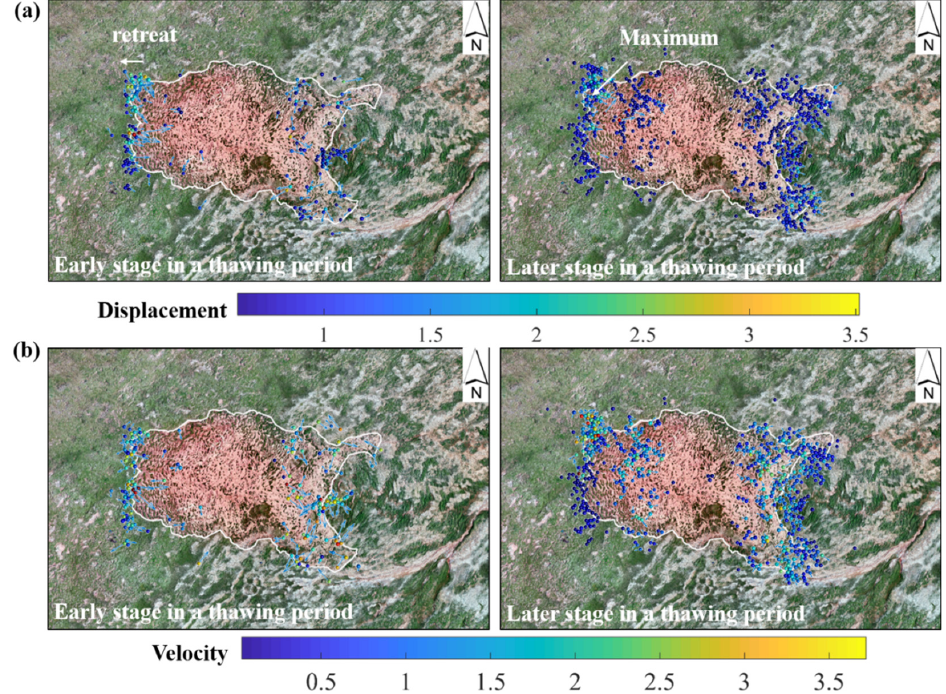
Figure 11. Simulated evolution of the K1129W thaw slump. ( a ) Displacement evolution of related elements. ( b ) Velocity evolution of related elements. Note that the white solid line represents the thaw slump boundary in September 2021.